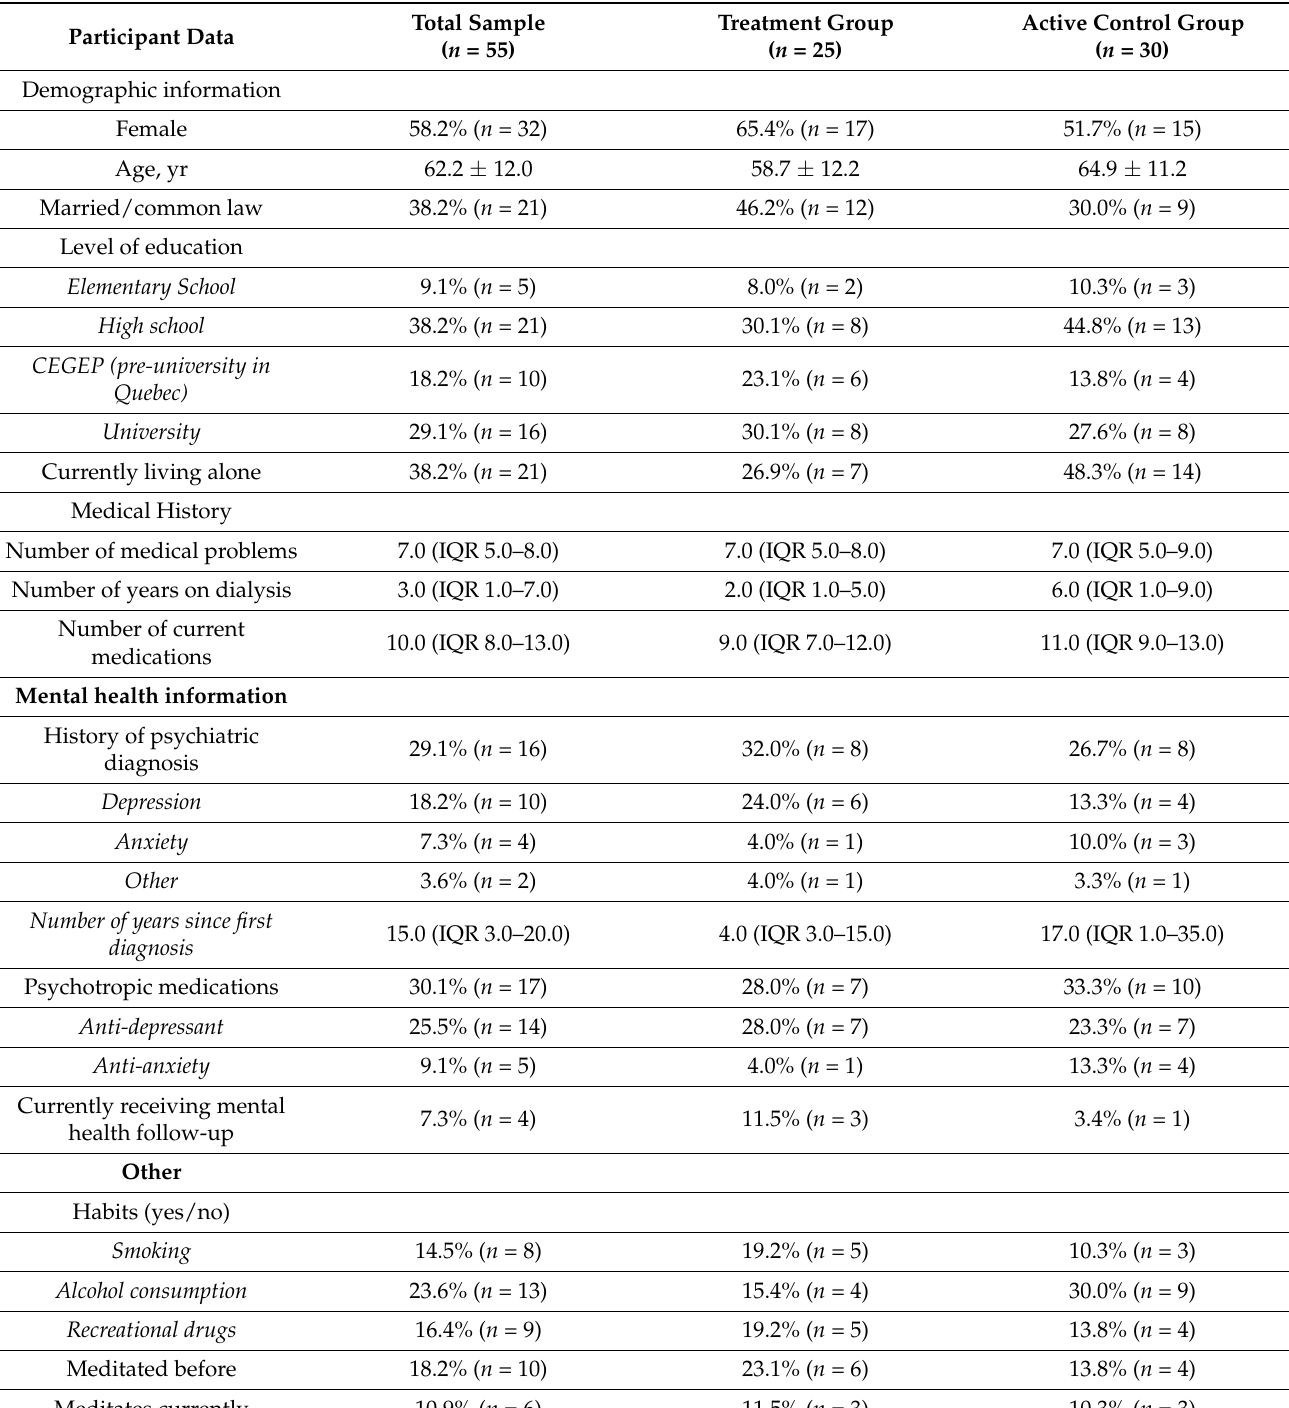
Table 1. Baseline Demographic and Clinical